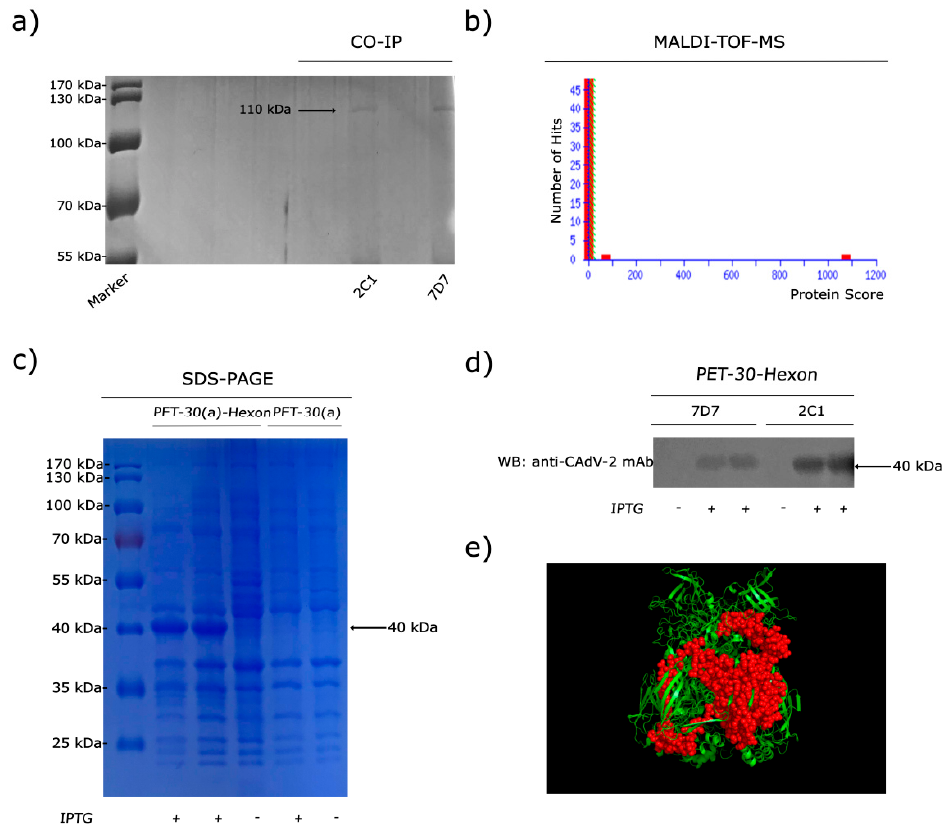
Figure 2. MAbs 2C1 and 7D7 react with the CAdV-2 hexon. ( a ) SDS-PAGE of CAdV-2 proteins after immunoprecipitation with mAbs 2C1 and 7D7. Marker: PageRuler Prestained Protein Ladder. ( b ) Results of MALDI-TOF-MS analysis. Protein scores (n = 1074 for mAbs) that were greater than 26 were significant ( p < 0.05). Protein scores were derived from ion scores as a non-probabilistic basis for ranking protein hits. ( c ) A truncated, recombinant peptide spanning the C-terminal 300 aa of the CAdV hexon protein was expressed in Escherichia coli . Coomassie-stained SDS-PAGE showing characteristic 40-kDa band; marker: PageRuler Prestained Protein Ladder. ( d ) Reactivity of the truncated hexon protein with mAbs 2C1 and 7D7 by Western blot analysis. ( e ) 3D structure of the expressed 300 aa from the truncated peptide (red spheres) predicted by the SWISS-MODEL online